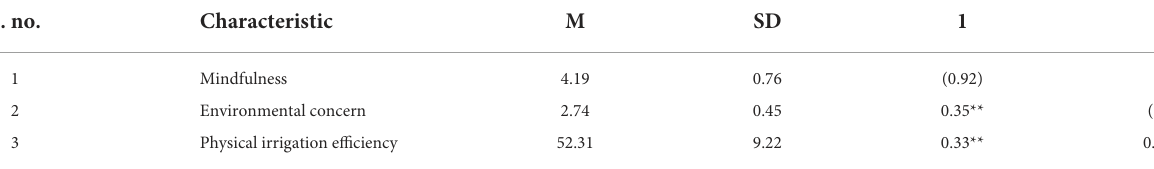
TABLE 1 Means, standard deviations, correlations, and reliabilities. S. no.